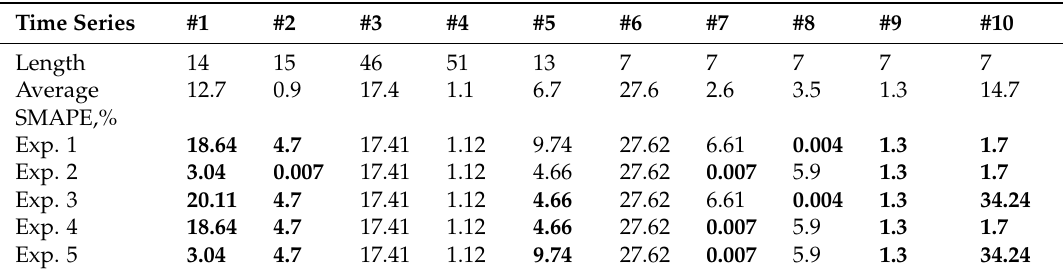
Table 8. Comparison of uniform and cluster